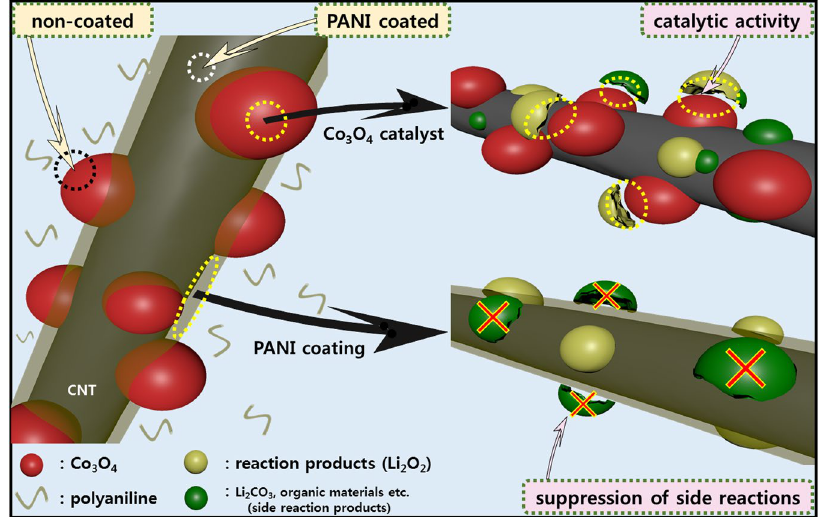
Figure 7. Schematic illustration demonstrating the synergic effect of the PANI layer and the Co 3 O 4 catalyst particles in the selectively PANI-coated CNT/Co 3 O 4